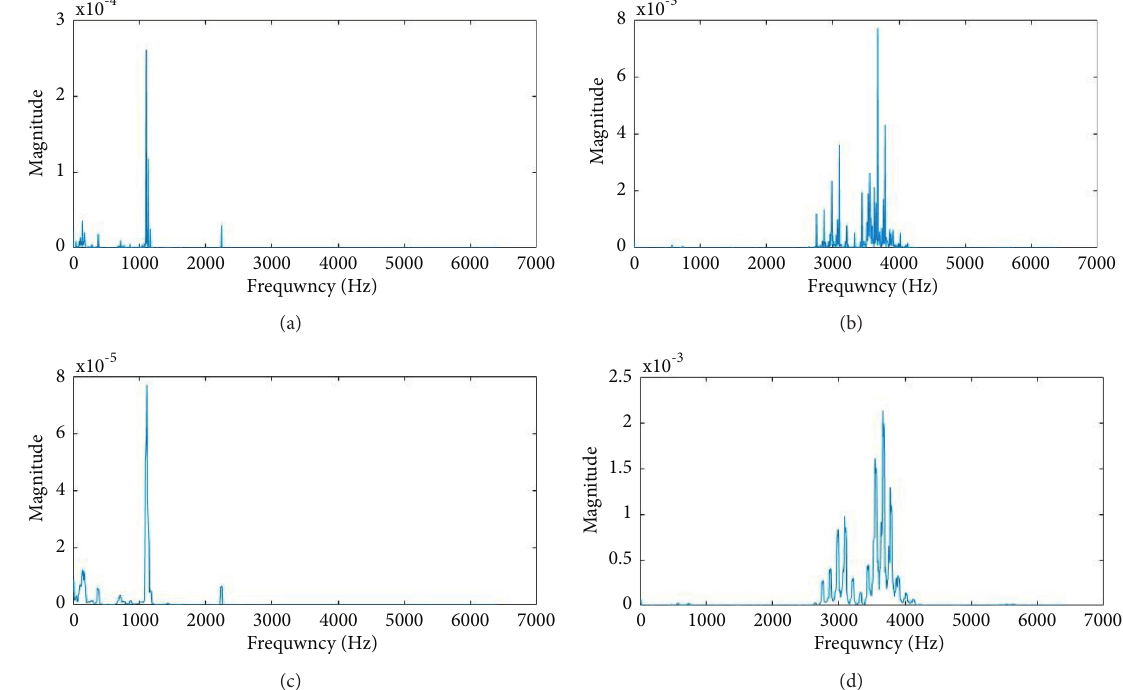
Figure 4: (a) Periodogram of the motor in good condition. (b) Periodogram faulty motor. (c) Smoothed estimate of the motor in good condition. (d) Smoothed estimate faulty